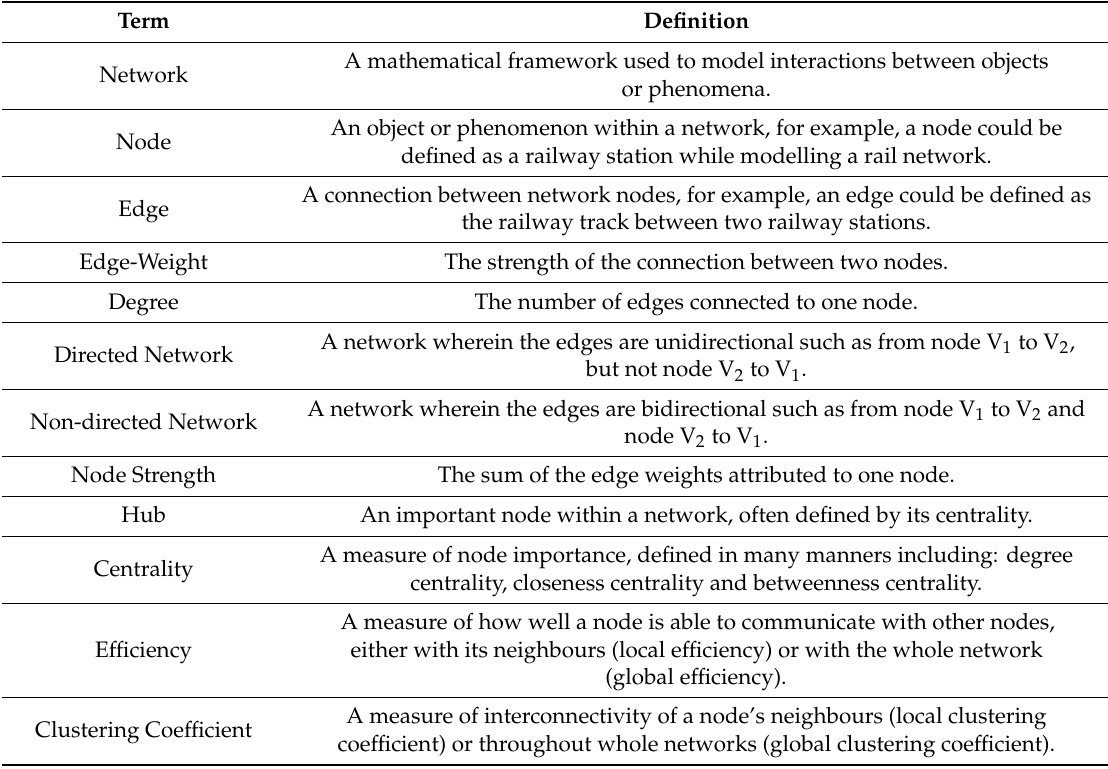
Table 1. Definitions of frequently used network